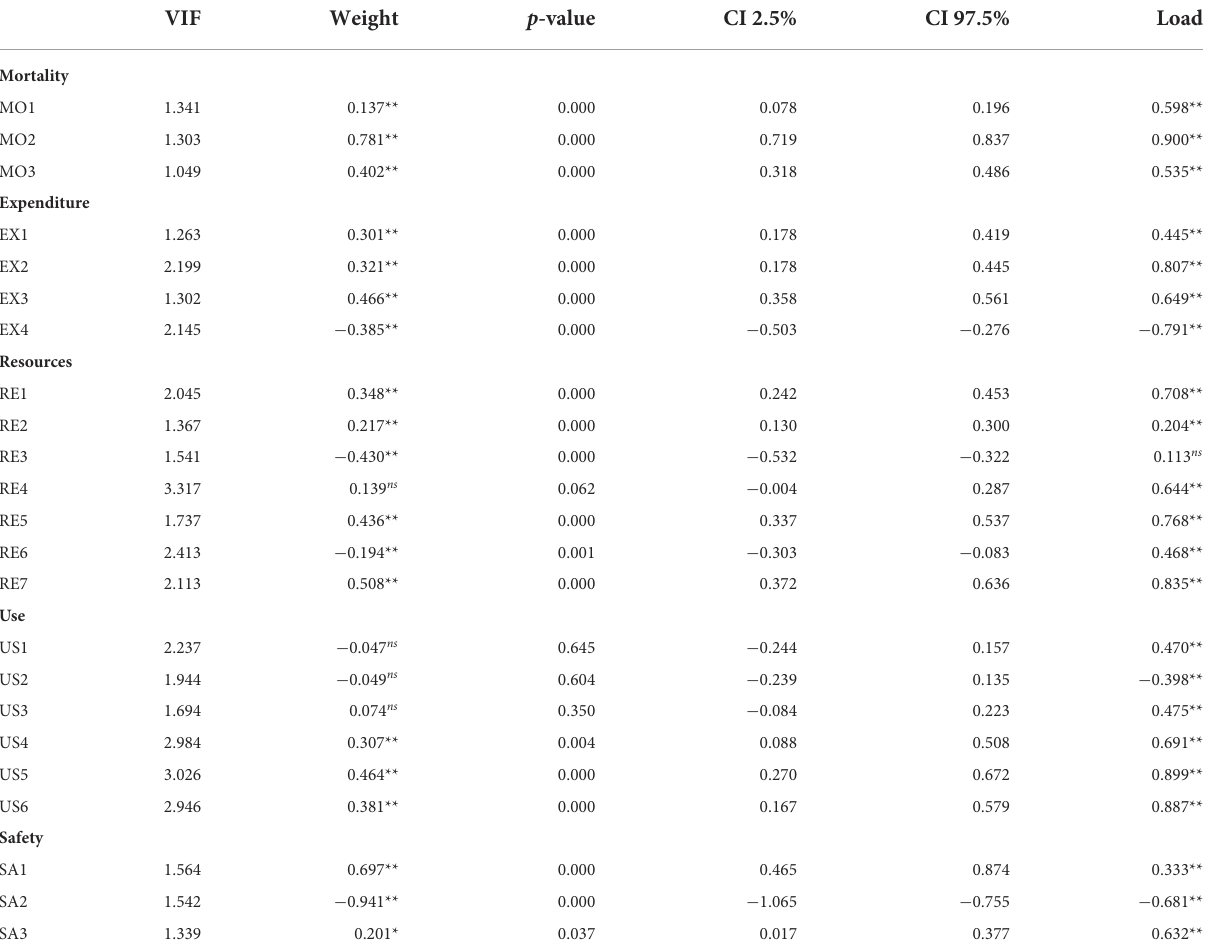
TABLE 4 Assessment of the measurement model. Formative constructs-mode